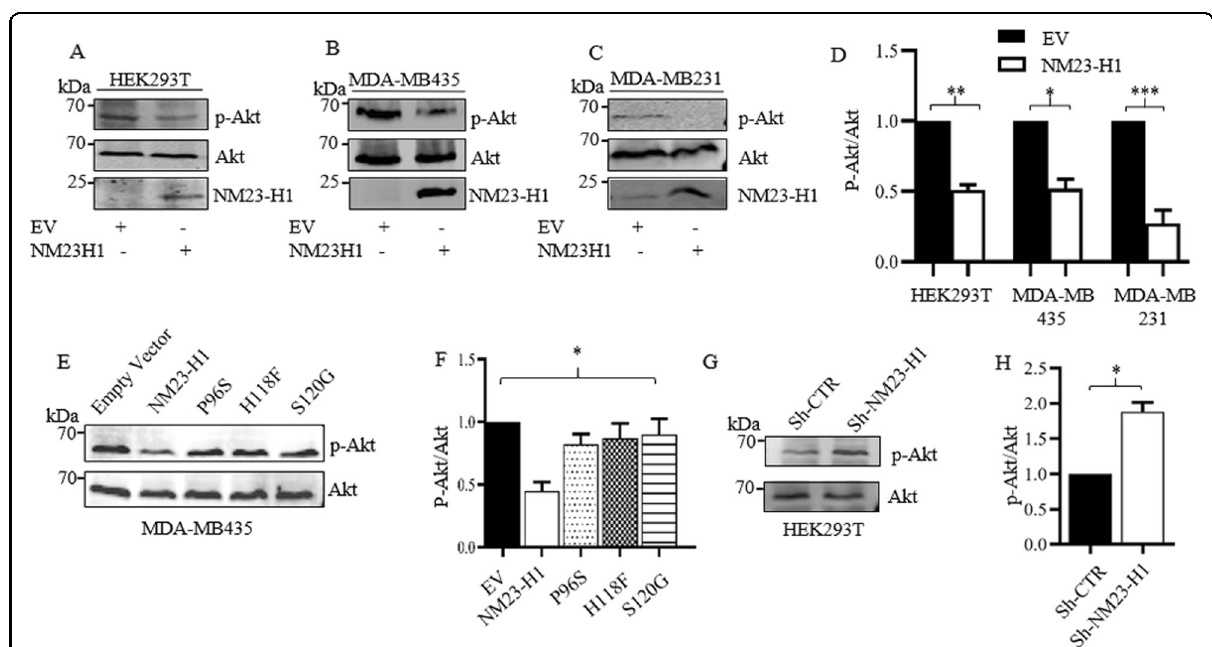
Fig. 3 Cells expressing NM23-H1 show a reduction in p-Akt levels. A – C Phosphorylated Akt was evaluated by immunoblot densitometry analysis and the normalized expression relative to total Akt was represented in the bar graph adjacent to the immunoblot ( D ). Western blot analysis on cell lysate from MDA-MB-435 expressing EV (empty vector), and the mutant proteins P96S, H118F, S120G results are shown in E . The Akt phosphorylated levels were normalized with total Akt protein levels ( F ). G , H Western blot analysis on cell lysates from HEK293T cells knock down for NM23-H1 expression using Sh-NM23-H1 (Short hairpin) showed increased levels of p-Akt. Fluorescent secondary antibodies were used, and quanti fi cation performed using the LI-COR Image Quant system and T -test statistical analyses were performed. N = 3. (* p <